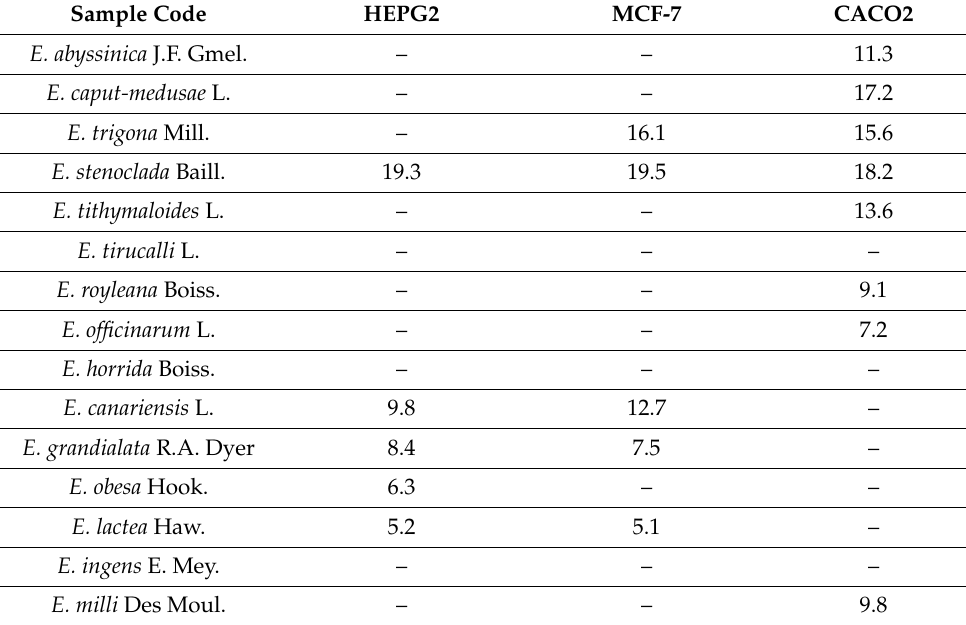
Table 1. IC 50 µ M values of methanolic Euphorbia extracts in different cancer cell lines.